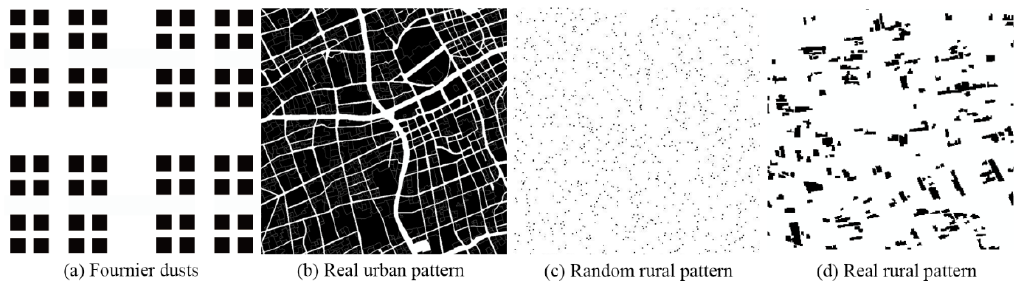
Figure 4. Theoretical and real urban and rural pattern.